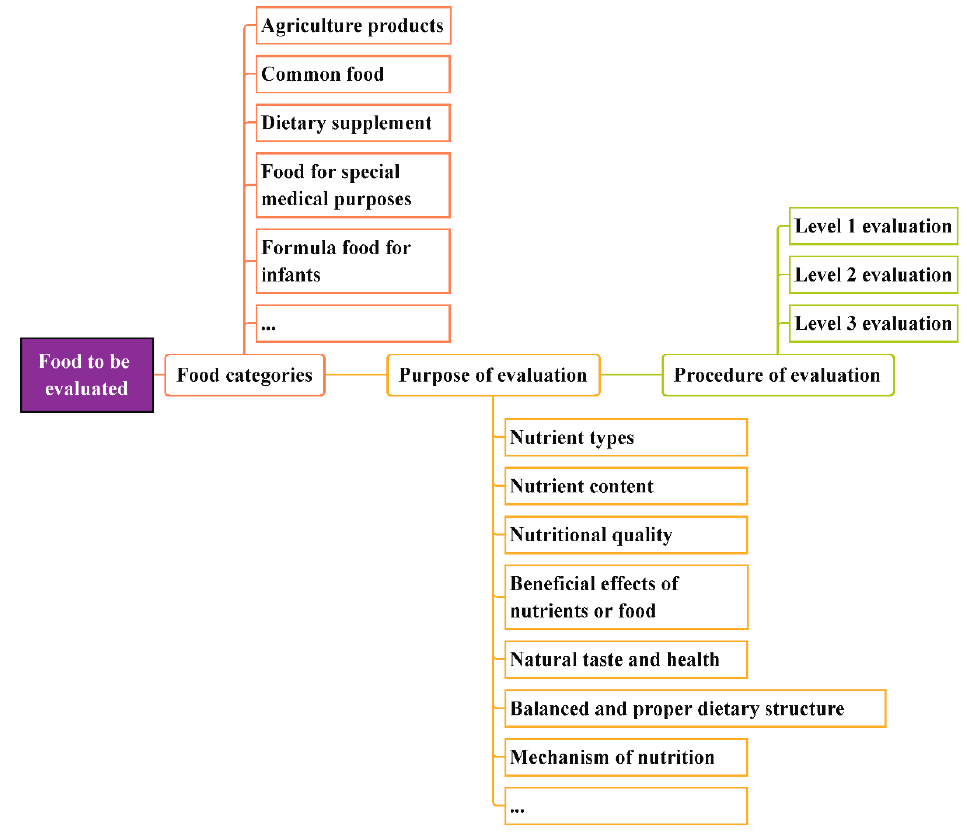
Figure 3. Procedures for evaluating the nutritional value of food.